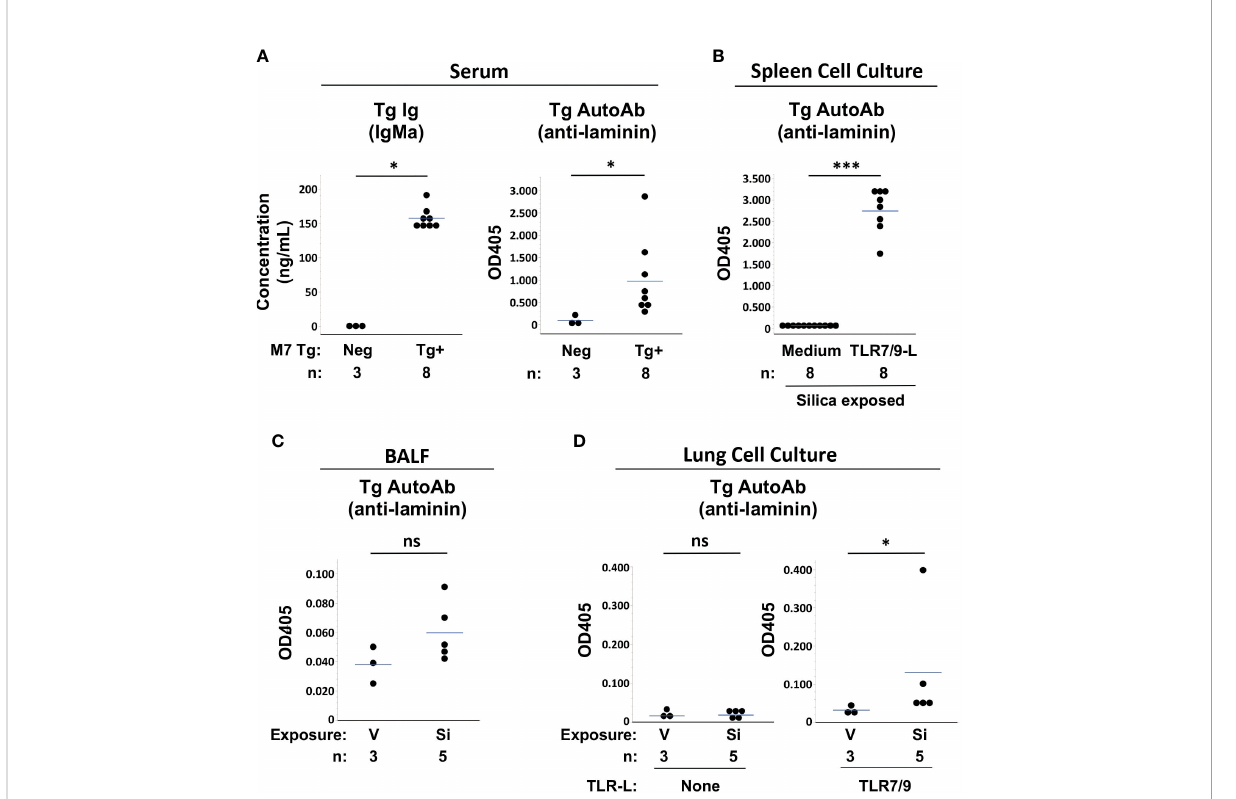
FIGURE 4 Autoantibody production in silica-exposed autoantibody transgenic (Tg) M7 Tg/WW mice. (A) Serum, (B) Spleen cell culture supernatants, (C) Bronchoalveolar lavage fl uid (BALF), and (D) Lung cell culture supernatants were assayed for transgene IgMa concentration or transgene anti- laminin IgMa autoantibody levels by ELISA. In (A) serum was obtained at the time of organ harvest for cSiO2- and vehicle-exposed Tg/WW mice; sera from 3 non-transgenic littermates were used as negative control for Tg Ig. Autoantibodies were measured in samples in duplicate using undiluted BALF and culture supernatants and serum diluted 1/20 for anti-laminin Ig. Isolated spleen and lung cells were cultured with medium alone or with a mixture of TLR7 and TLR9 ligands (TLR7/9-L) R848 and CpG oligos. Each circle represents an individual mouse; the bar indicates the mean for each group; *p < 0.05; ***p < 0.001; ns, not signi fi cant; Wilcoxon rank sum